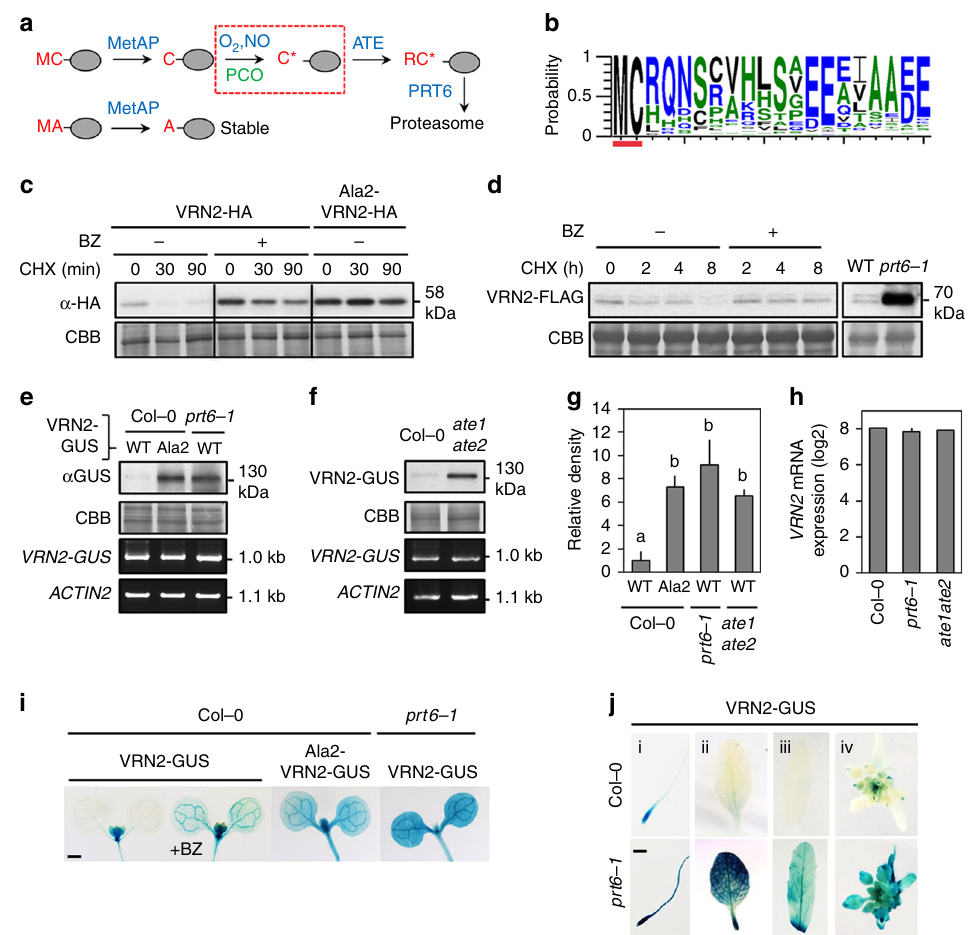
Fig. 1 VRN2 is a substrate of the Arg/N-end rule pathway of proteolysis. a N-terminal processing events leading to degradation of Met-Cys- (MC)-proteins via the Arg(R)/N-end rule pathway: MetAP methionine aminopeptidase, PCO plant cysteine oxidase (speci fi c to plants), ATE arginyl transferase, PRT6 proteolysis 6, C* Cys-sul fi nic acid (oxidised Cys); red box is gas-dependent step. b Probability plot of AA by position in VRN2-like sequences derived from sequenced angiosperms following MUSCLE alignment, highlighting the conserved MC N-terminus (red bar). See Supplementary Data 2 for sequence data. c In vitro cycloheximide (CHX) chase of WT and mutant (Ala2) VRN2-HA (±bortezomib; BZ). CBB Coomassie brilliant blue (showing equal loading). d CHX-chase of VRN2-FLAG in 7-day-old seedlings ±BZ treatment, and steady state levels in prt6-1 vs WT. e , f Protein and mRNA levels of WT and mutant (Ala2) VRN2-GUS in Col-0, prt6-1 and ate1 ate2 seedlings. g VRN2-GUS protein accumulation in Col-0, prt6-1 and ate1 ate2 shown as relative density. Data is averaged from western blots for three independent lines for each transgene (see also Supplementary Figure 1a and b). Letters indicate one-way ANOVA; Tukey ’ s test. h VRN2 mRNA expression levels in Col-0, prt6-1 and ate1 ate2 , taken from published microarray data 19 . i Histochemical staining of 7-day-old Col-0 or prt6-1 seedlings expressing WT or mutant (Ala2) VRN2-GUS± BZ. Lines are the same as those presented in ( e ) and ( f ). Scale bar 500 μ m. See also supplementary Figure 2a for biological reps. j Histochemical staining of (i) 7-day-old seedling primary root tip, (ii) rosette leaf, (iii) cauline leaf and (iv) in fl orescence of Col-0 and prt6-1 lines expressing WT VRN2-GUS. Scale bar in (i), 500 μ m. Source data are provided as a Source Data fi